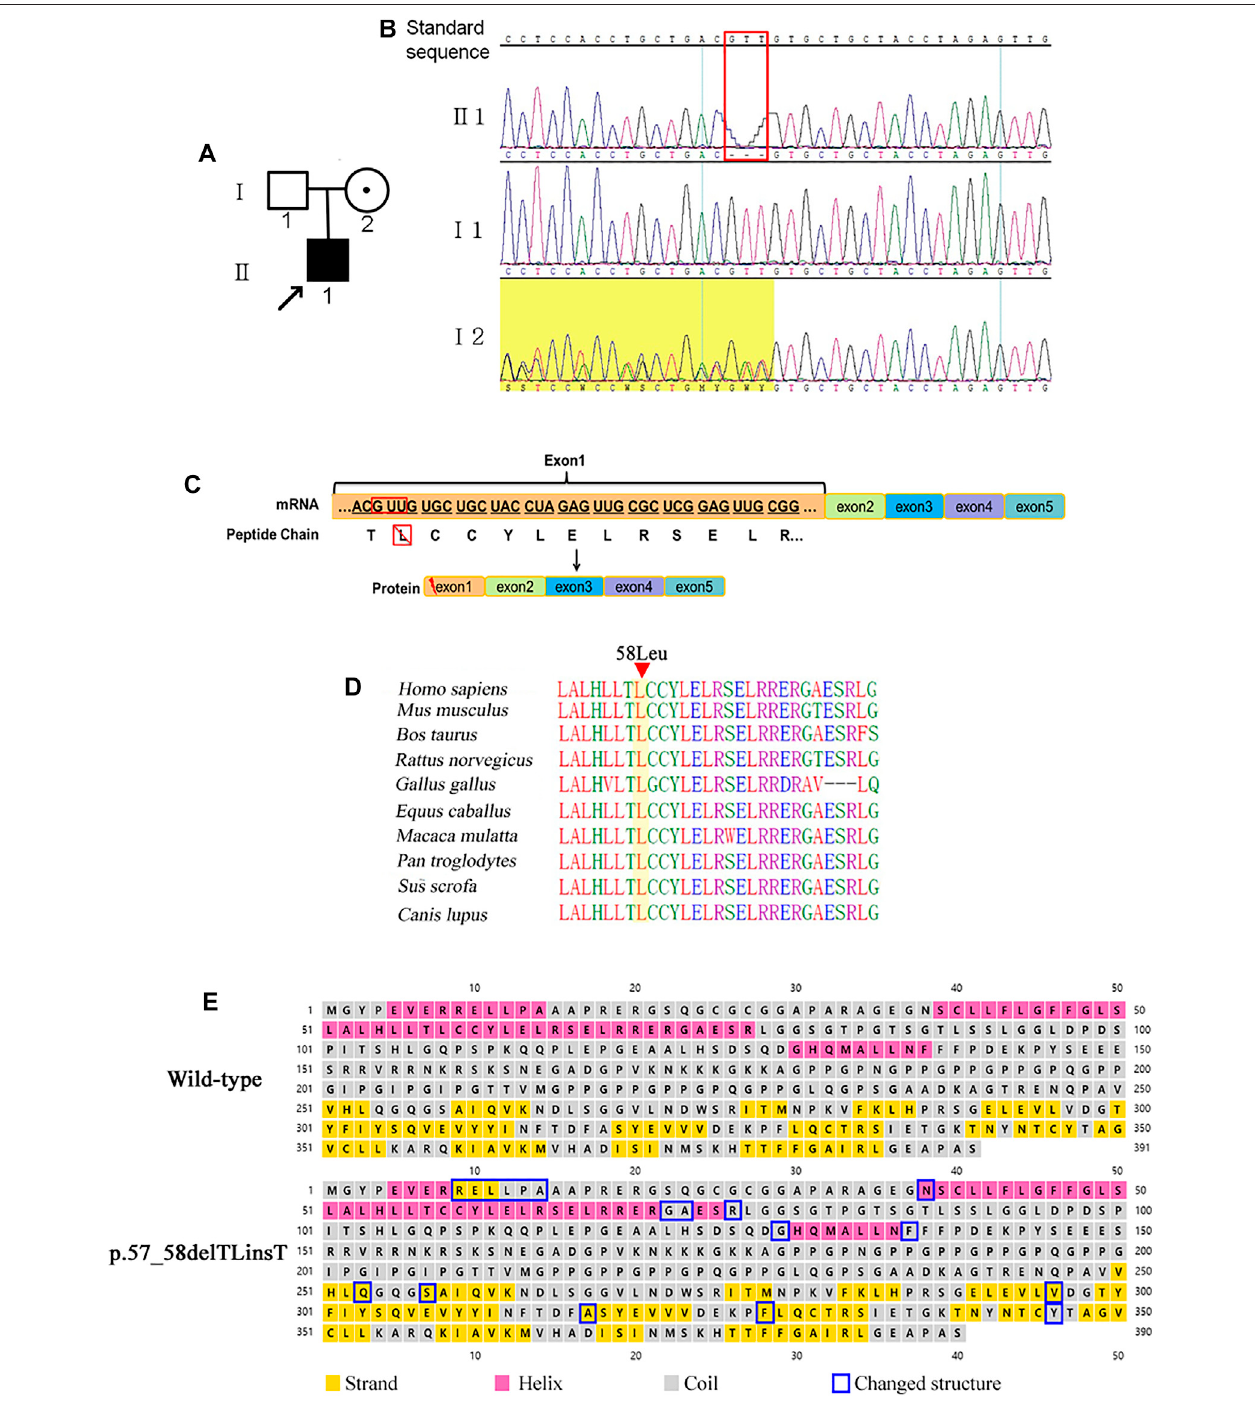
FIGURE2| Variantsincase2. (A) FamilytreeshowingthemutationsinheritedfromI2. (B) Validationofthemutationsite(c.171_173delGTT)bySangersequencing. (C) Transcription pattern. (D) Conservation analysis of affected amino acids in the EDA protein among 10 different mammalian species. (E) Secondary structure prediction of the WT EDA protein and the p.57_58delTLinsT mutant.